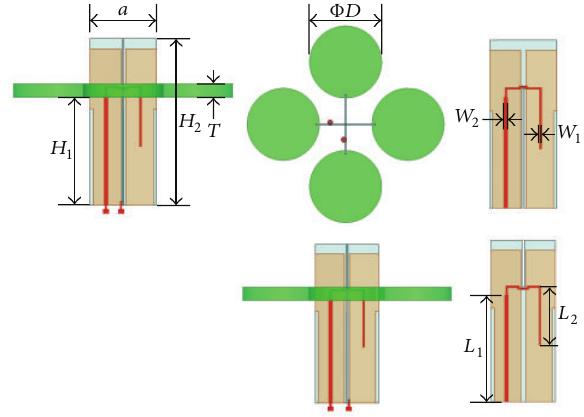
Figure 6: Geometry of the proposed antenna.